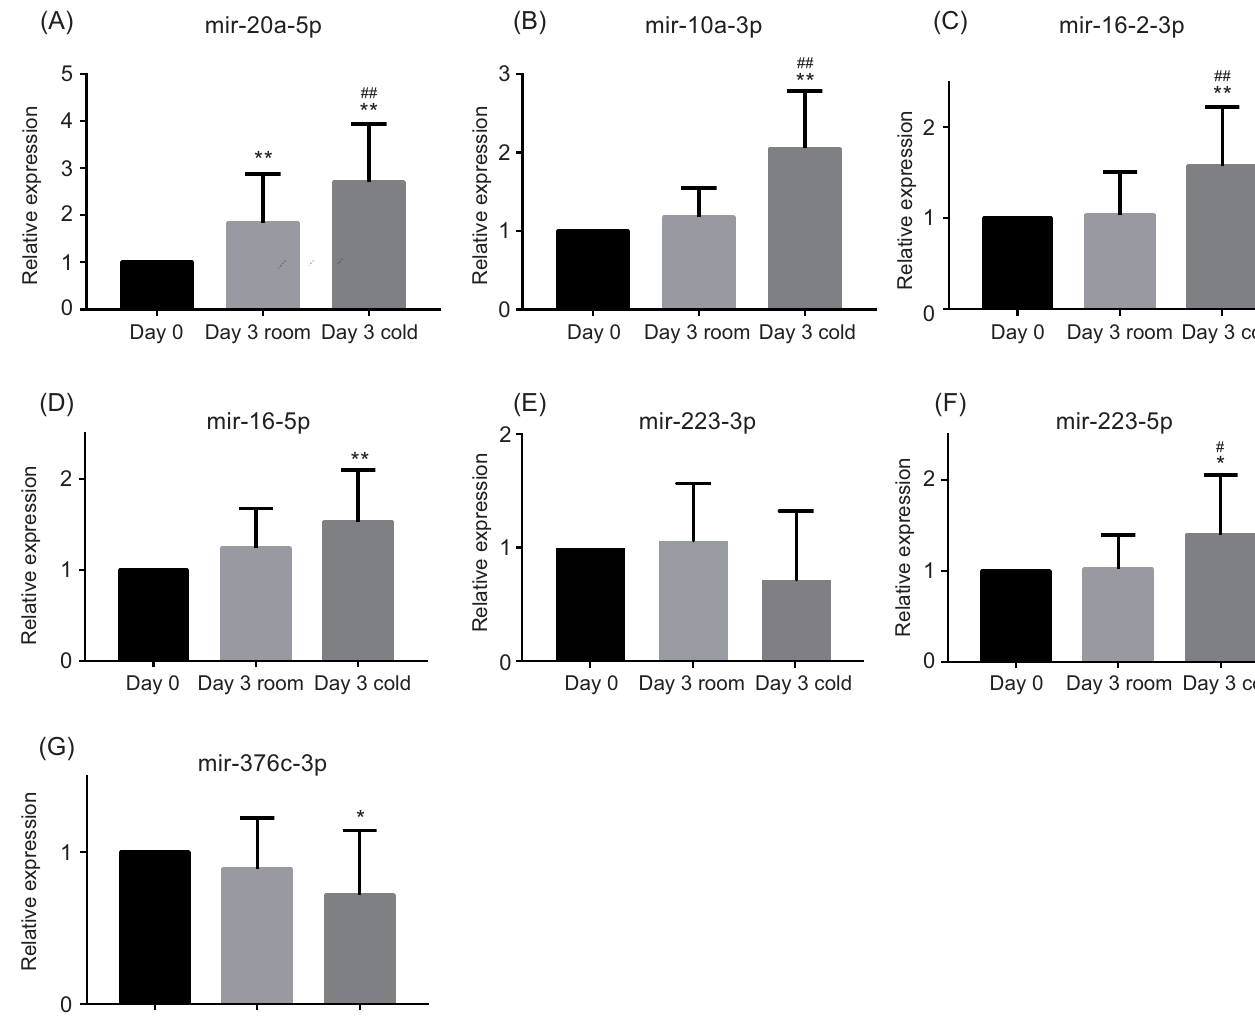
Fig 2. Differential microRNA profiling with qPCR. Data represent the mean + standard deviation (SD). � P < 0.05, �� P < 0.01 vs. Day 0. # P < 0.05, ## P < 0.01 vs. Day 3 room.